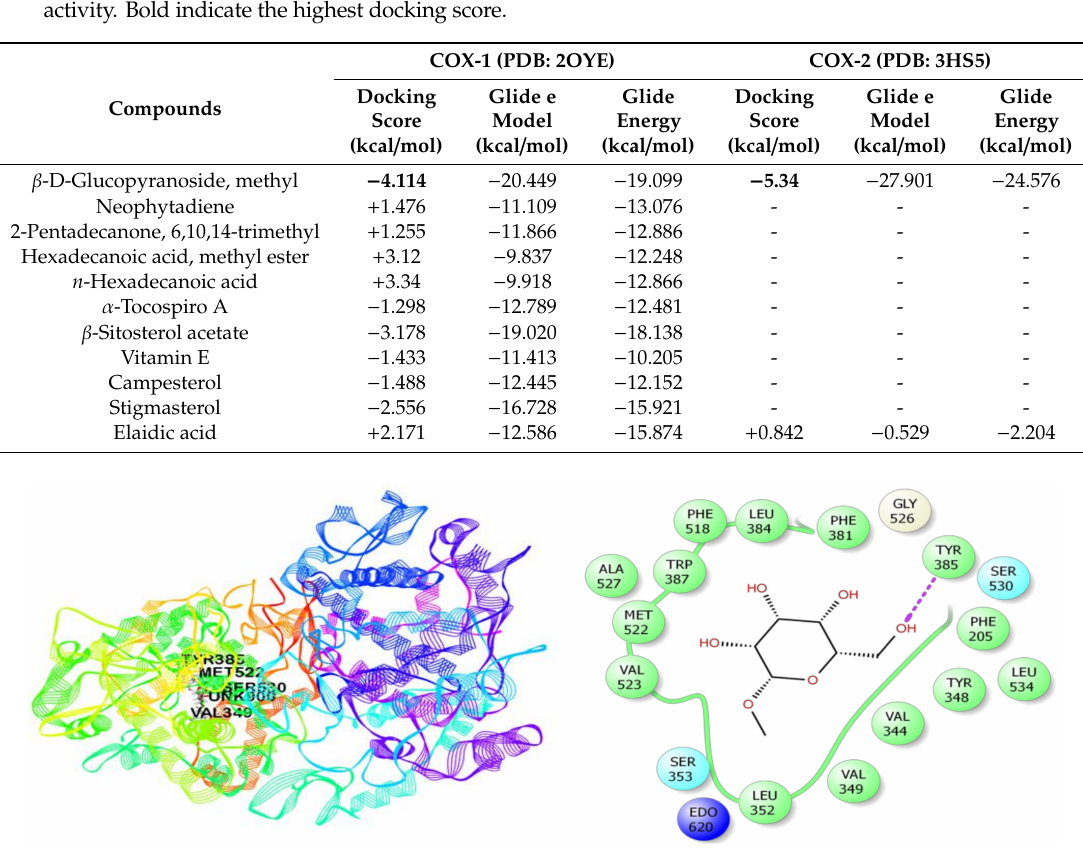
Figure 10. Best ranked poses and 2D interactions of β -D-Glucopyranoside, methyl with COX-2 enzyme (pdb: 3HS5) for anti-inflammatory